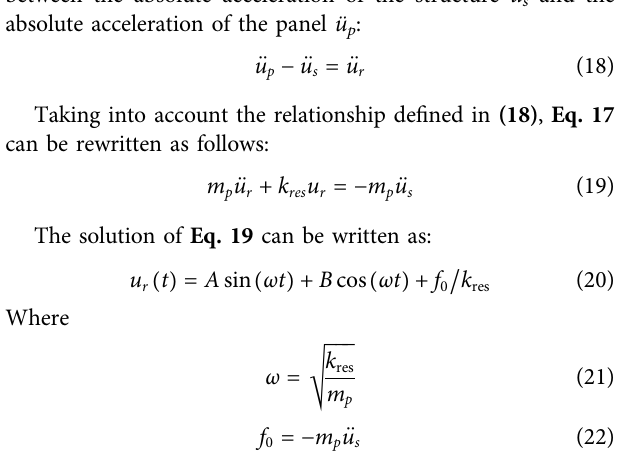
Frontiers in Built Environment |